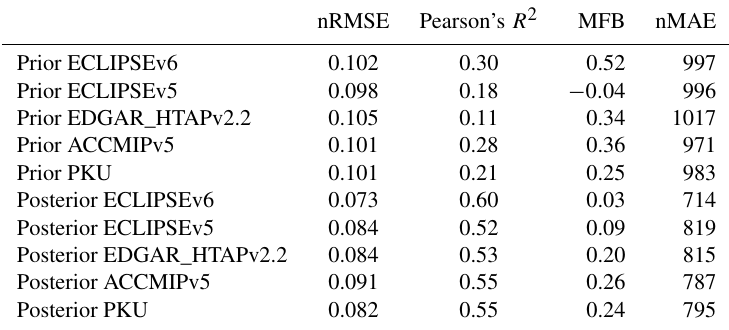
Figure 2. Scatter plots of prior and posterior concentrations against dependent observations (observations that were included in the in- version framework) from ACTRIS from January to April 2020. Four statistical measures (nRMSE, Pearson’s R 2 , MFB and nMAE) were used to assess the performance of each inversion using five different prior emission inventories for BC (ECLIPSEv5, v6, ACCMIPv5, EDGAR_HTAPv2.2 and PKU). Table 2. Statistical measures (RMSE, Pearson’s R 2 , MFB and nMAE) for each of the prior and posterior concentrations against dependent observations (observations that were used in the inversion algorithm) for BC (eBC). Note that the inversion using ECLIPSEv6 prior emission dataset gave the best agreement with the observations, and therefore the results of this inversion are presented